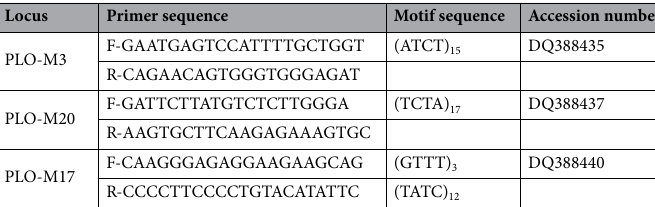
Table 2. Primer of the microsatellite region that we designed